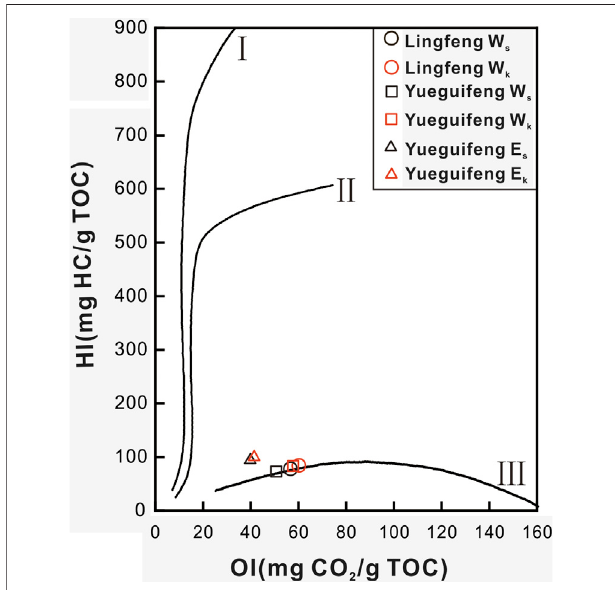
FIGURE 2 | Kerogen type classi fi cation of the selected samples. Note: W s , source rock in the West subsag; W k , corresponding kerogen in the West subsag; E s , source rock in the East subsag; E k , corresponding kerogen in the East subsag.